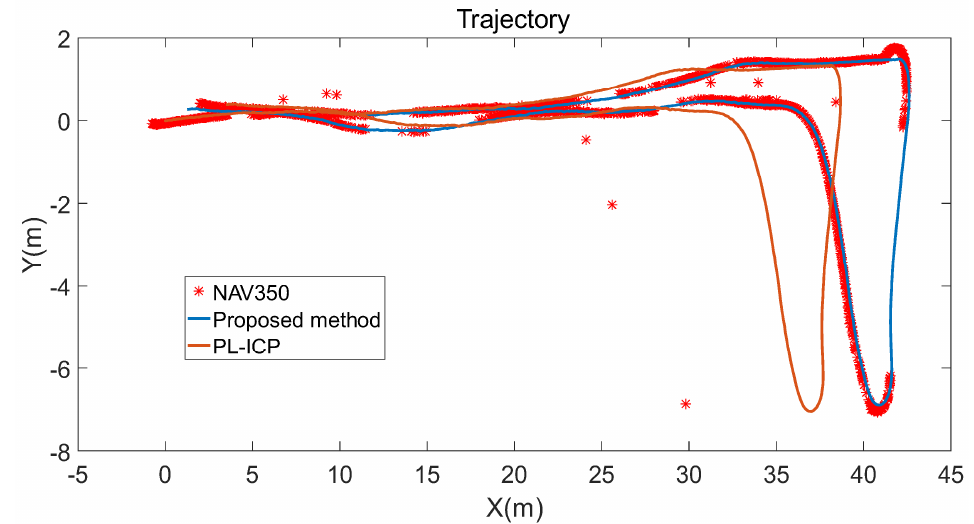
Figure 19. Trajectories of the three positioning algorithms. Red points are the positions calculated by NAV350. The blue line is the trajectory calculated by the proposed method. The brown line is the trajectory calculated by the traditional least square.